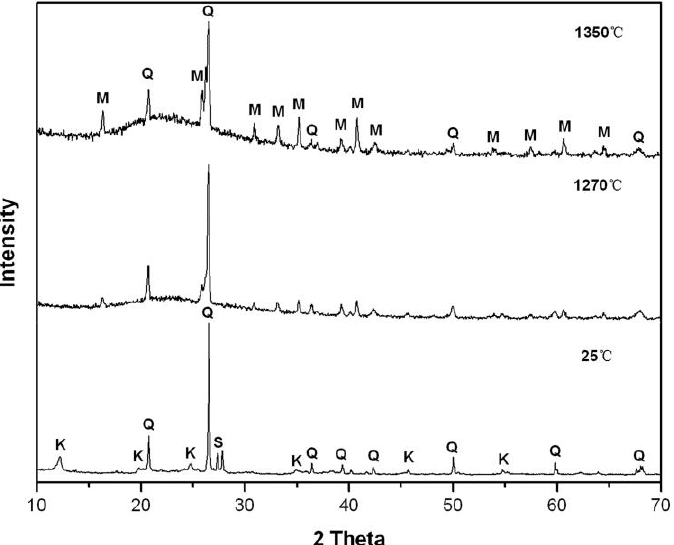
Figure 3. XRD patterns of M1 at 1270 °C and 1350 °C for 2 h; Q: quartz, M: mullite, K: kaolinite, S: sanidine.